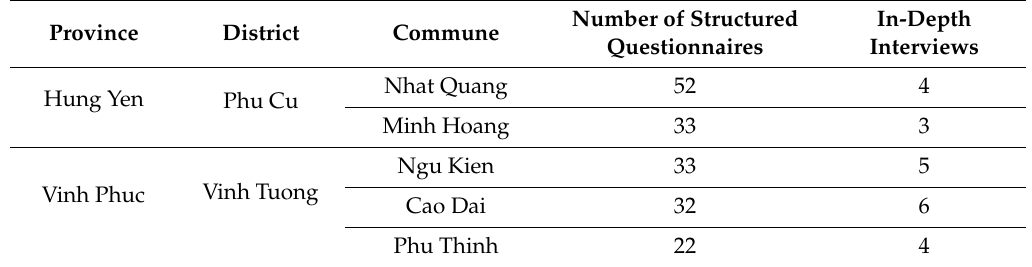
Table 2. The numbers of structured questionnaires and in-depth interviews in the study areas. Province District Commune